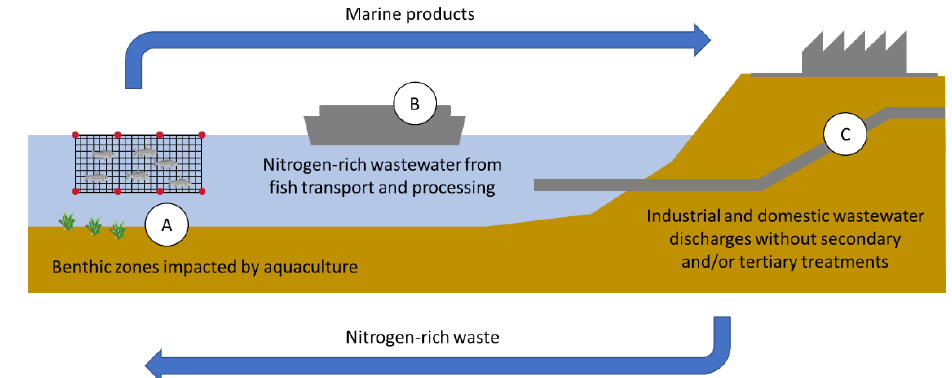
Figure 4. Visualized opportunities to develop METs for carbon and nitrogen removal in coastal and marine environments.